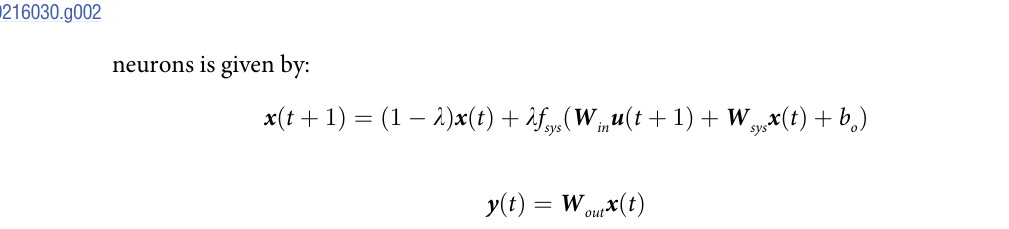
Fig 2. Dataset with weight, pyloric caecal T/C ratio, CF, and SGR. Data5 of Nile tilapia at adult stage with 31 data points. Weight, T/C ratio, CF, and SGR values will be normalized to a range of between –1 and +1 for training and testing our models. (original data personally provided by Karun Thongprajukaew, Prince of Songkla University,